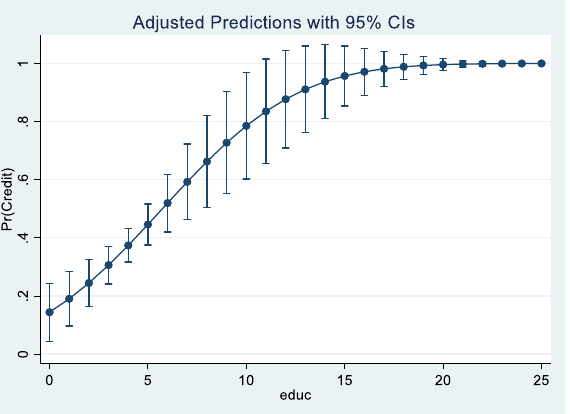
Figure 5. The non-linear impact of education level on the probability to adopt credit as a risk management strategy